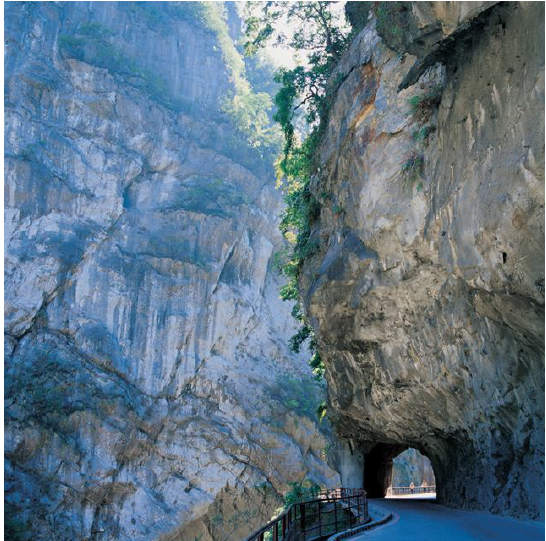
Figure 3. Taroko Gorge